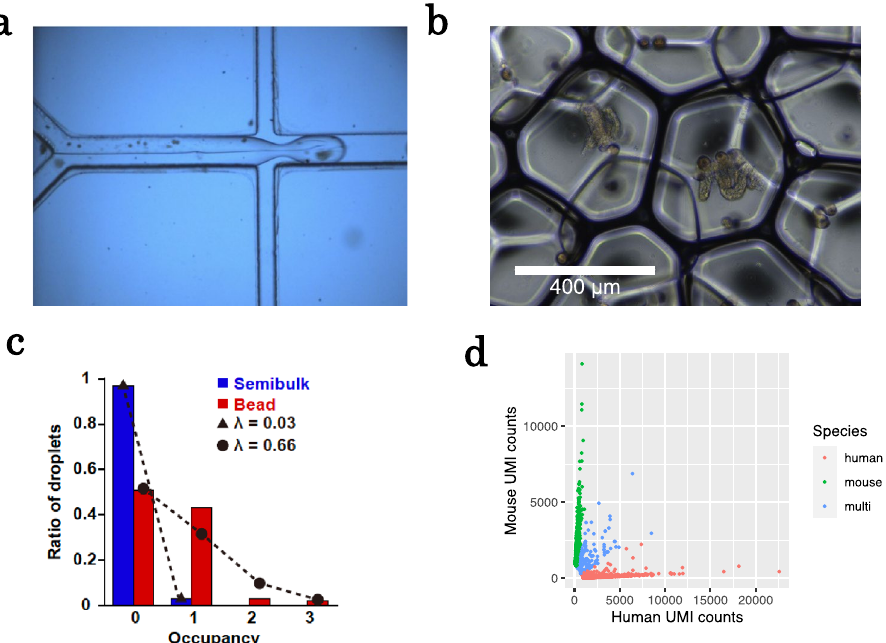
Figure 2. Encapsulation of semibulks with barcoded beads and cross-species validation. ( a ) A picture of microfluidic device for microdroplet generation. ( b ) A picture of microdroplets. ( c ) The distribution of ratio of droplets (containing from zero to three beads or semibulks) fitted with the Poisson distribution. The fitted expected values λ for semibulks and beads were 0.03 and 0.66, respectively. ( d ) UMI counts, aligned to human and mouse genomes, of the data from the cell mixture. 1451 (47.6%), 1416 (46.4%), and 184 cells (6.0%) were judged as human, mouse cells, and multiplets of these cells,